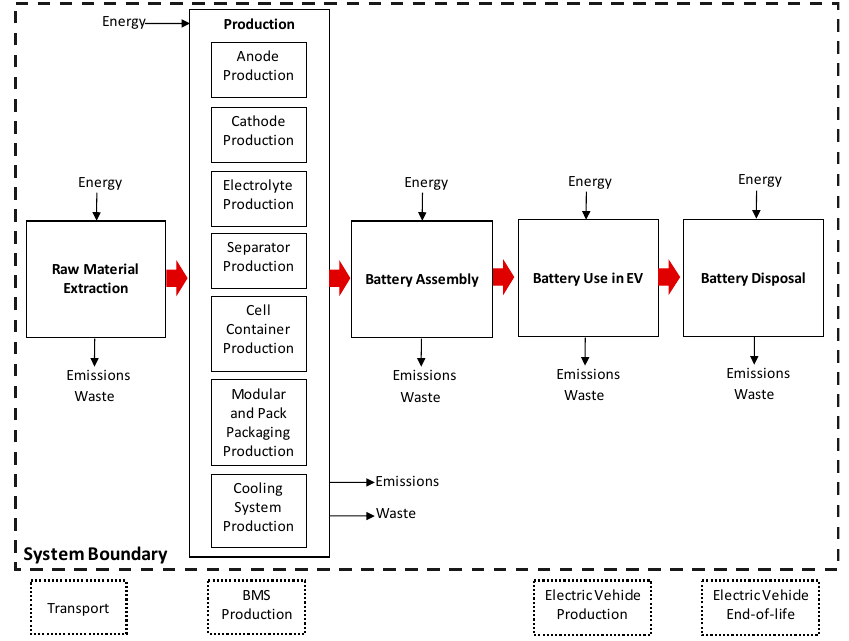
Figure 3. System boundary for the Life Cycle Assessment (LCA) of the 50 kWh Li-Sulfur (Li-S)